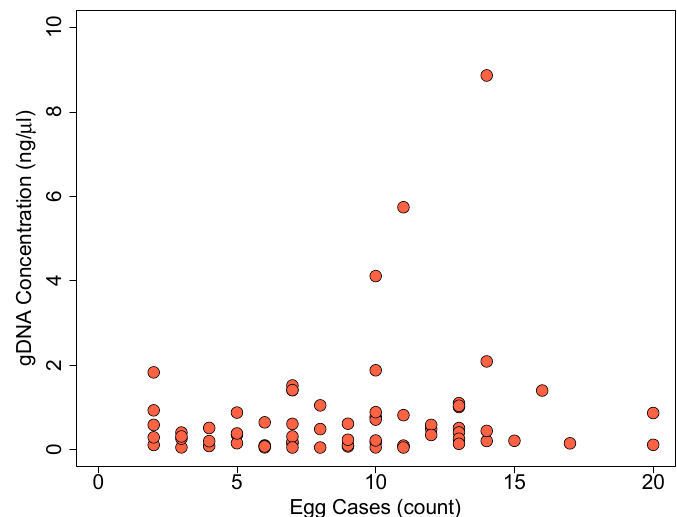
Figure 3. Relationship of genomic DNA yield and the number of egg cases per field collected samples (n = 79) of C. thomasi bethunebakeri . There was no statistical correlation between DNA concentration and the number of egg cases (r = 0.180, p = 0.138). Table 1. Hierarchical test of molecular variance to test for genetic variation in COI (n = 58) and EF1 (n = 27) genes associated with burn unit and locality for field collected egg case samples of C. thomasi bethunebakeri.